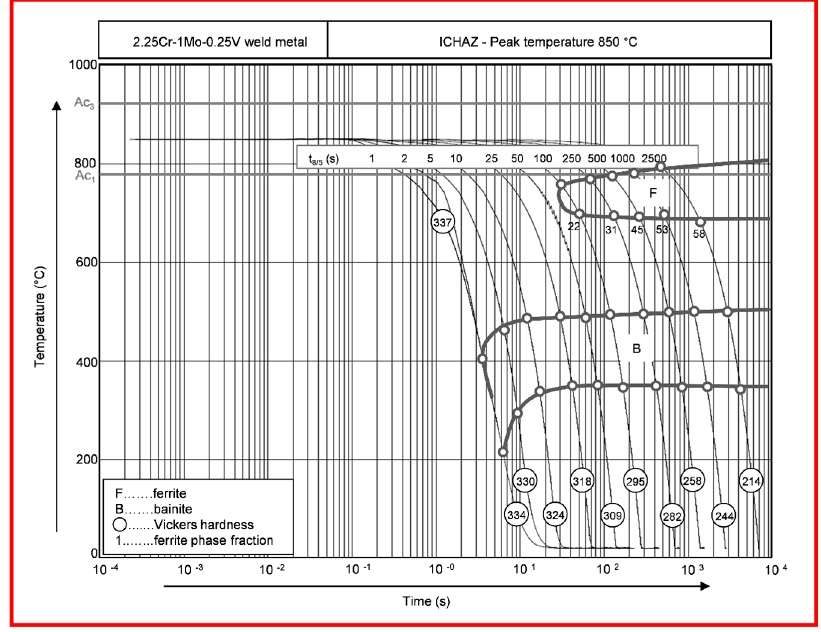
Figure 9. CCT diagram for the ICHAZ between the weld beads of a 2.25Cr-1Mo-0.25V multi-layer SAW all-weld metal with a peak temperature of 850 °C.